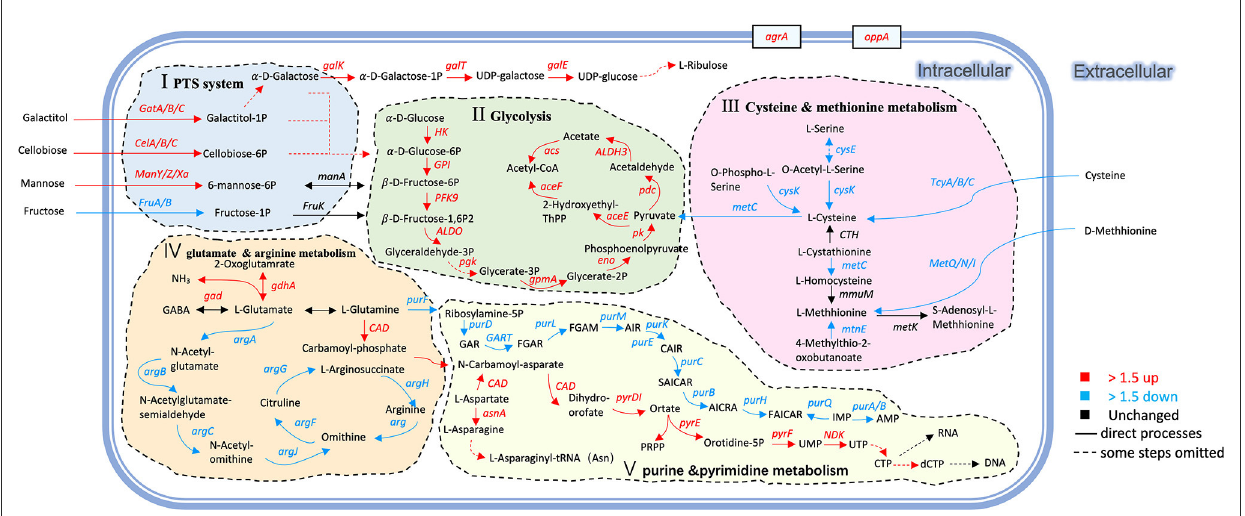
FIGURE5 Changes of genes and proteins in L. paraplantarum RX-8 response to inducing effect from W. anomalus Y-5. The serial number (I, II, III, IV, V) indicates the response pathways of L. paraplantarum RX-8 under co-culture. (I) improving PTS and enhancing the uptake of certain sugars; (II) increasing the key enzyme activity in glycolysis, then promoting the energy production; (III) repressing the precursor of QS signal AI-2; (IV) decreasing arginine biosynthesis to increase glutamate mechanism, then promote plantaricin yield; (V) changing the expression of several genes/proteins related to purine metabolism (downregulation) and pyrimidine metabolism (upregulation). Pathways were constructed based on information provided in the KEGG database and previous studies.